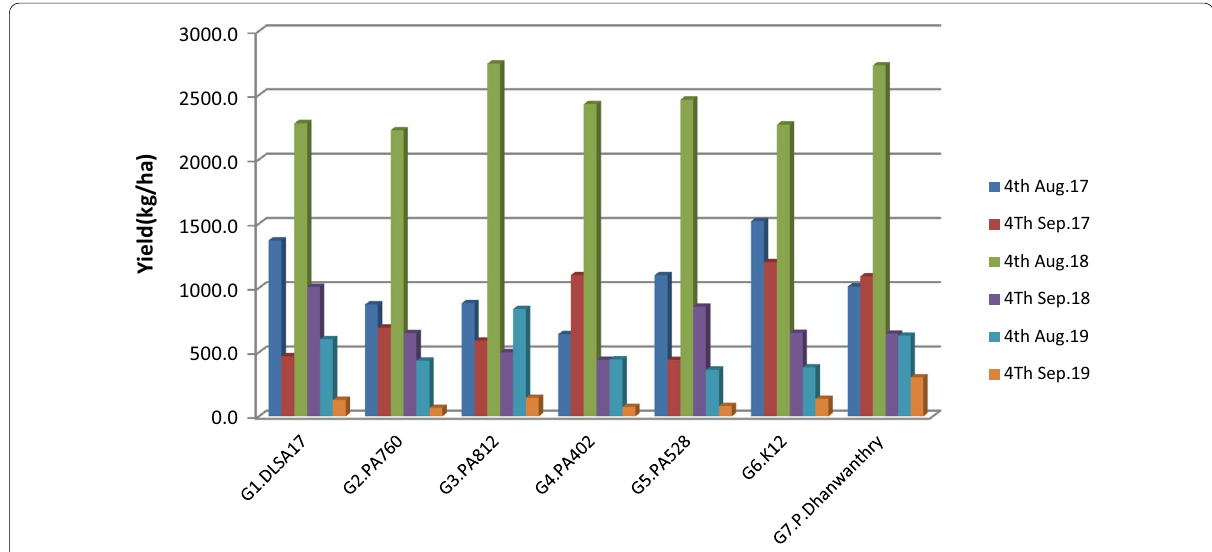
Fig. 1 Seed cotton yield (kg/ha) by genotypes and times of